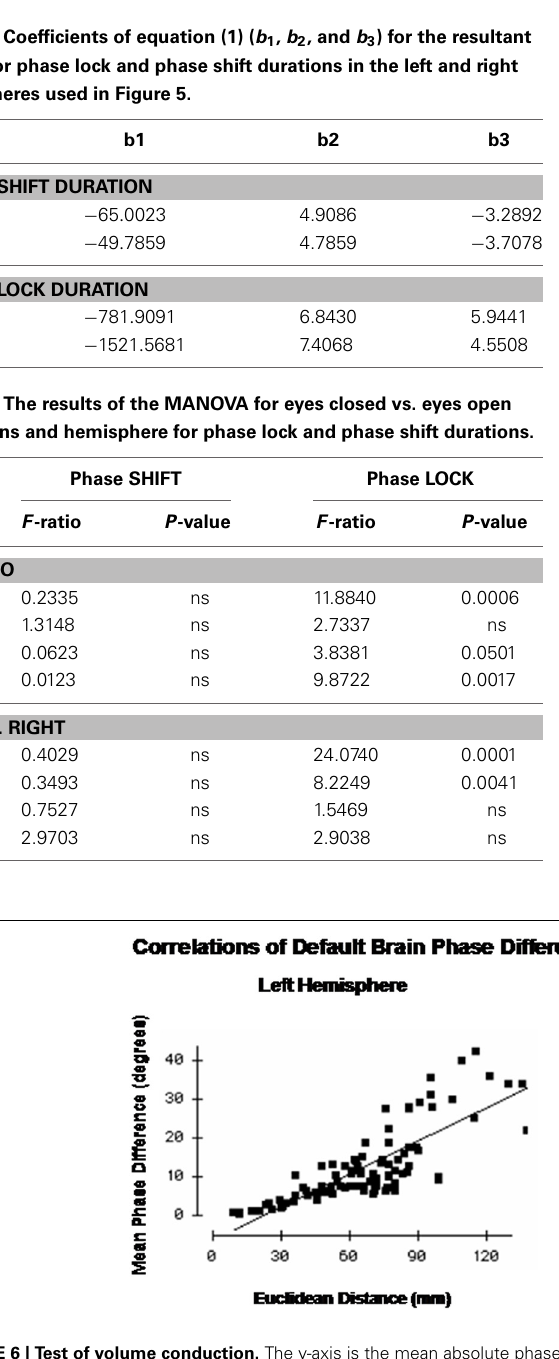
Frontiers in Human